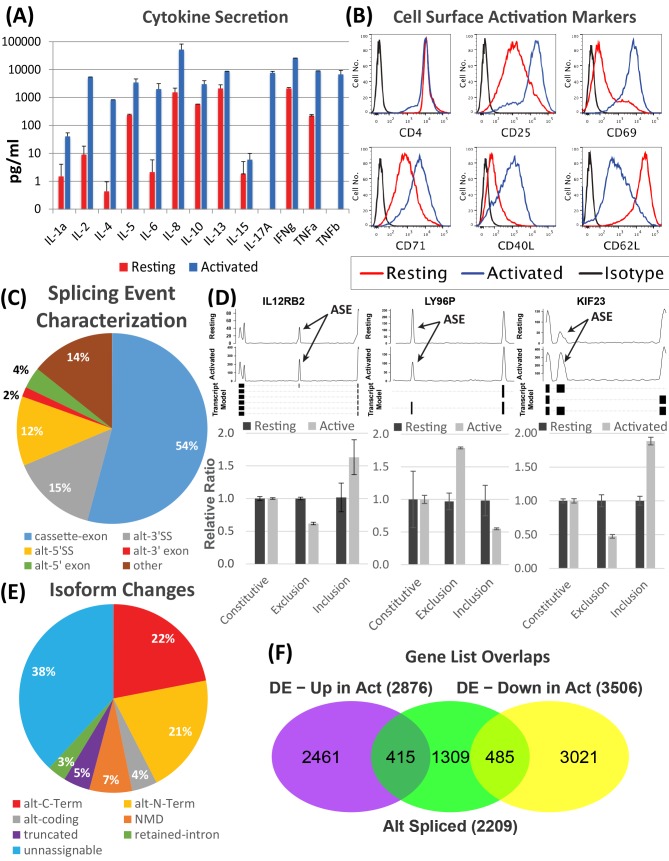
Protocol for primary T cell culture displays phenotypic markers and transcriptional changes indicative of activation.(A) ELISA results for secretion of 12 cytokines in resting and activated CD4 T cell cultures. Error bars represent mean ± S.E.M. (n = 3). (B) Histogram depicts expression of the T cell marker CD4 and various activation markers (CD25, CD69, CD71, CD62L, and CD40L) from FACS analysis of resting (red) and activated (blue) CD4 T cell cultures. (C) Breakdown of differential splicing events between resting and activated CD4 T cell culture based on RNASeq data using Alt-Analyze (ASPIRE > 0.2 & p-value < 0.1, S1 Table). (D) RT-qPCR validation of alternative splicing in RNAseq data for IL12RB2, LY96P, & KIF23. ASE–Alternatively Spliced Exon. Error bars represent mean ± S.D. (n = 3). (E) Breakdown of isoform changes by type between resting and activated T cells identified by Alt-Analyze in RNAseq data. (F) Three classes of gene expression are demonstrated after T cell activation: 1) DE, alone (5303); 2) DE+AS (1079); 3) AS, alone (1281). This data is also shown for DE—upregulated and DE—downregulated. DE–Differentially Expressed; AS–Alternatively Spliced.